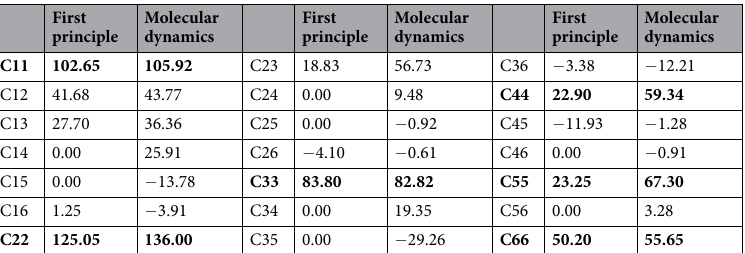
Table 1. Comparison of elastic constants (GPa) of tobermorite (The bold values are for elastic modulus along 6 main